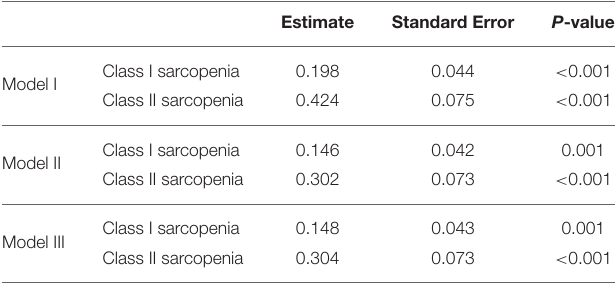
TABLE 3 | Multivariate analysis to determine the significance of sarcopenia in arterial stiffness.